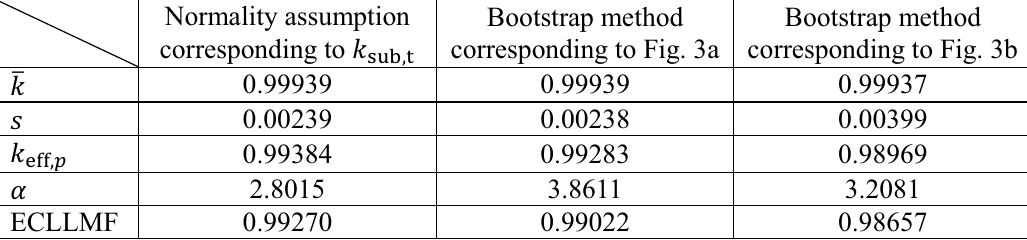
Figure 3. Probability Density Distribution of Calculated Effective Multiplication Factor and Bootstrap Distribution (a) without Consideration of Neutronic Similarity and Uncertainties of Effective Multiplication Factor and (b) with Consideration of Neutronic Similarity and Uncertainties of Effective Multiplication Factor. Table II. Summary of Estimated Criticality Lower-Limit Multiplication